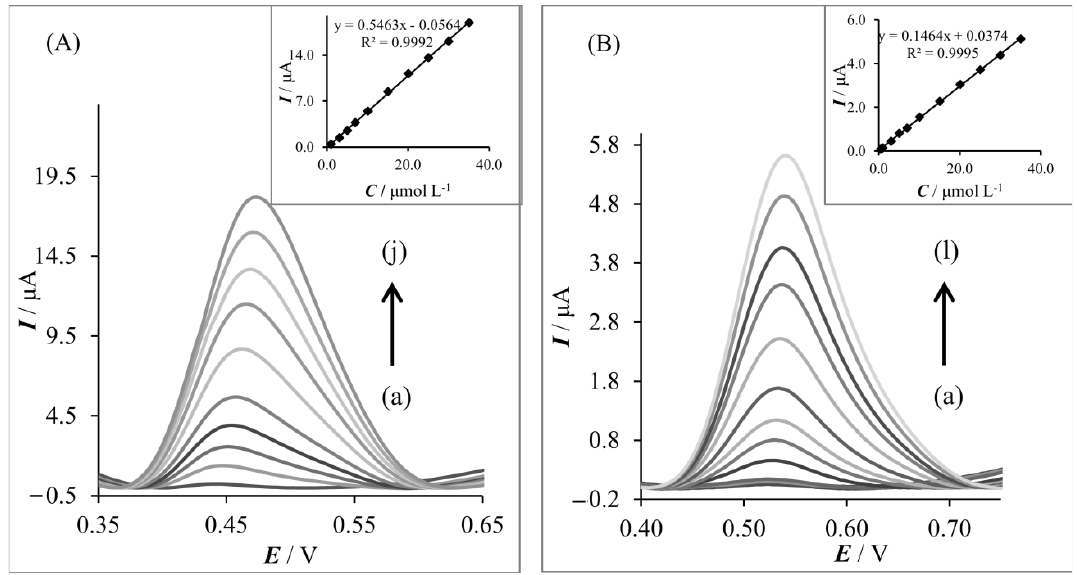
Figure 6. ( A ) SWS voltammograms of AC on GFPE: (a) 1.0 μmol L −1 , (b) 3.0 μmol L −1 , (c) 5.0 μmol L −1 ,